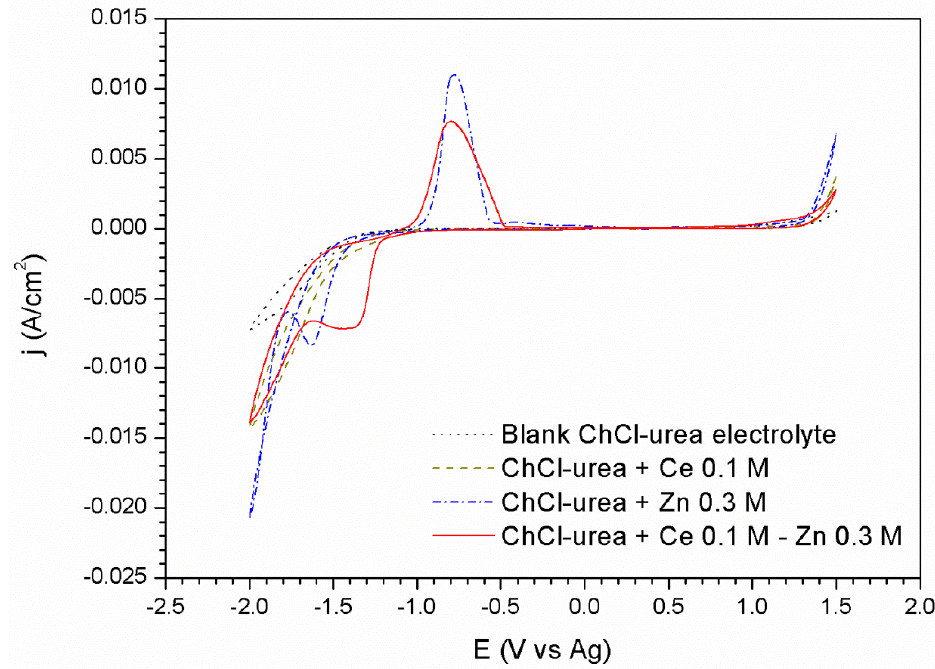
Figure 1. Voltammograms corresponding to the platinum substrate: in the blank ionic liquid, with 0.3 M of Zn salt, and with 0.3 M of Zn salt and 0.1 M of Cerium salt.